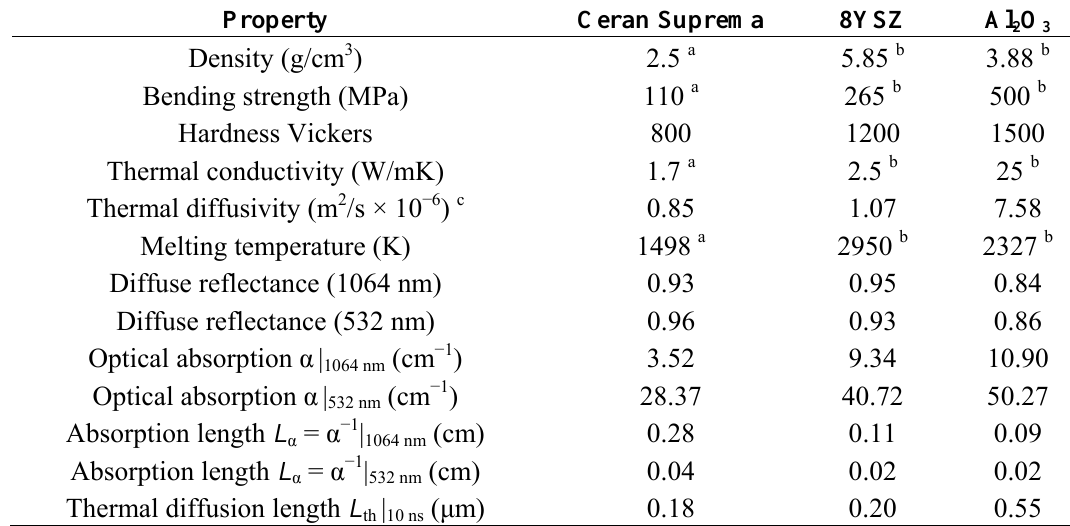
Table 1. Properties of glass-ceramic and advanced ceramic substrates.